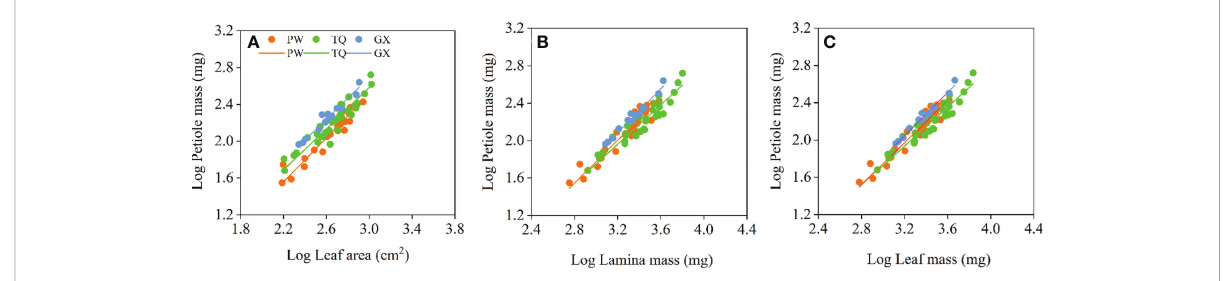
FIGURE 4 Growth relationships between petiole mass and leaf area (A) , petiole mass and lamina mass (B) , petiole mass and leaf mass (C) in three latitude regions. PW, Pingwu; TQ, Tianquan; GX,